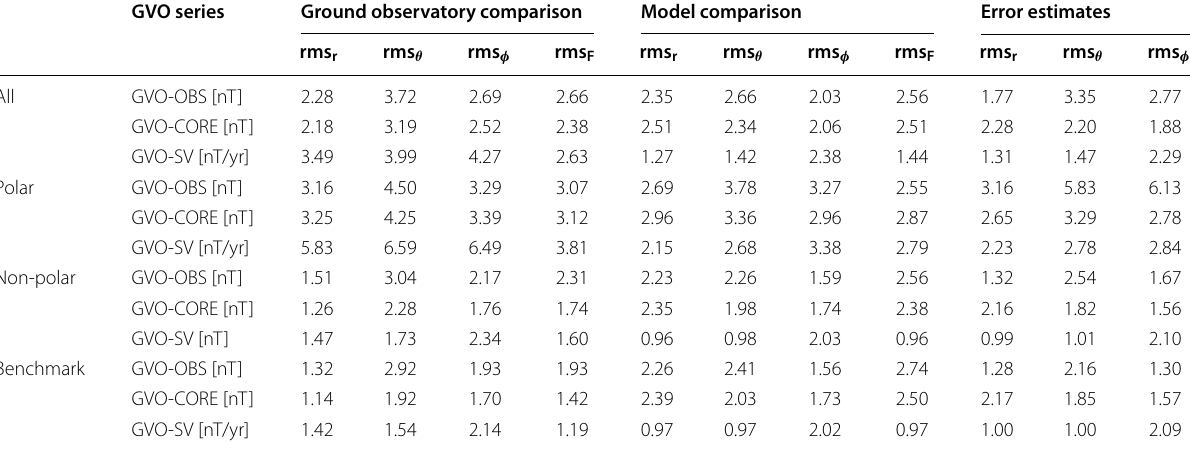
Table 4 Summary of validation tests for the 4-monthly GVO